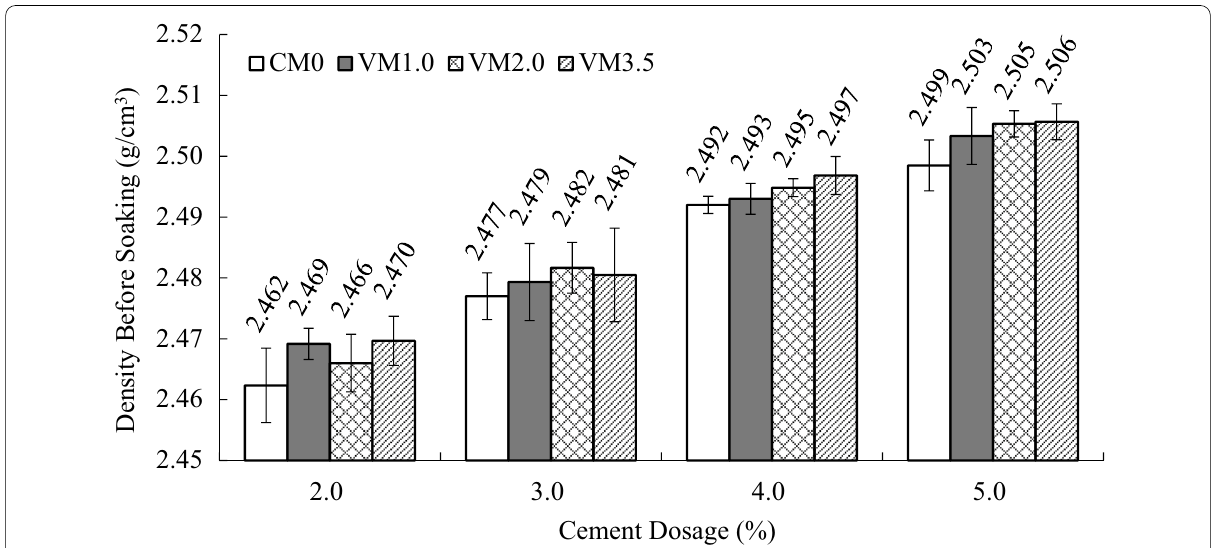
Fig. 9 Comparison of the effect of different mixing methods on the average density of CSM with different cement